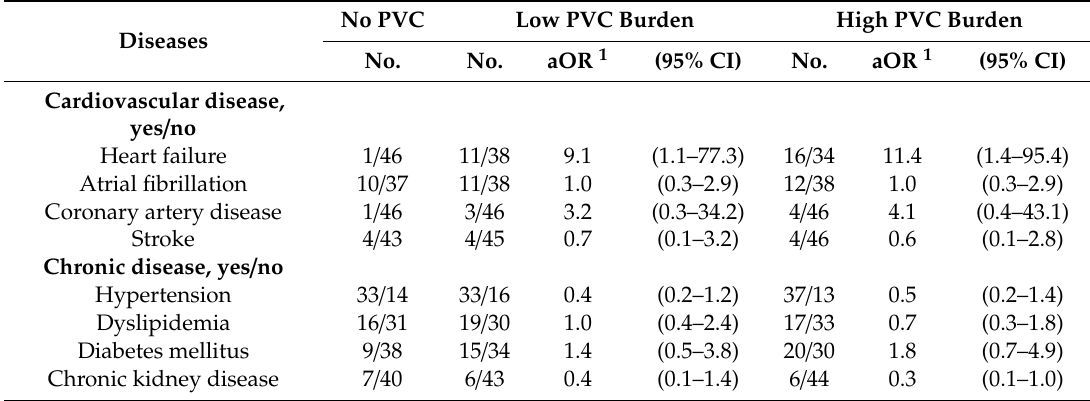
Table 4. Adjusted odds ratio (aOR) of premature ventricular contractions (PVC) associated with cardiovascular and chronic diseases among Holter monitor patients.